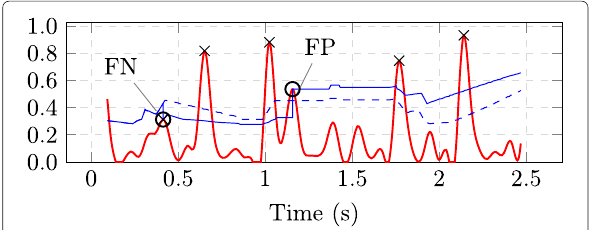
Fig. 3 Evolution of θ( t ) throughout time as the result of user interaction in the sliding window percentile-based approach: symbol (cid:2)(cid:11)(cid:3) Fig. 2 Evolution of θ throughout time as the result of user interactions shows the ground truth onsets while ( (cid:6) ) represents the (cid:2)(cid:11)(cid:3) in the threshold-based approach: symbol shows the ground performed interactions. Dashed and solidlines represent the static and truth onsets while ( (cid:6) ) represents the performed interactions. interactive thresholds obtained with the sliding window approach, Dashed and solidlines represent the static ( θ 0 ) and interactive respectively. Initial percentile θ( t i = 0 ) has been set to 50th (median thresholds, respectively